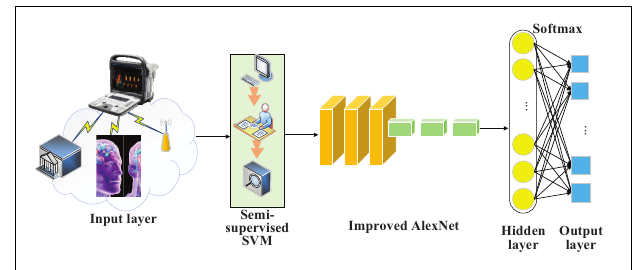
FIGURE 3 | Flowchart of extracting and classifying the data features in brain image DTs based on CNN.